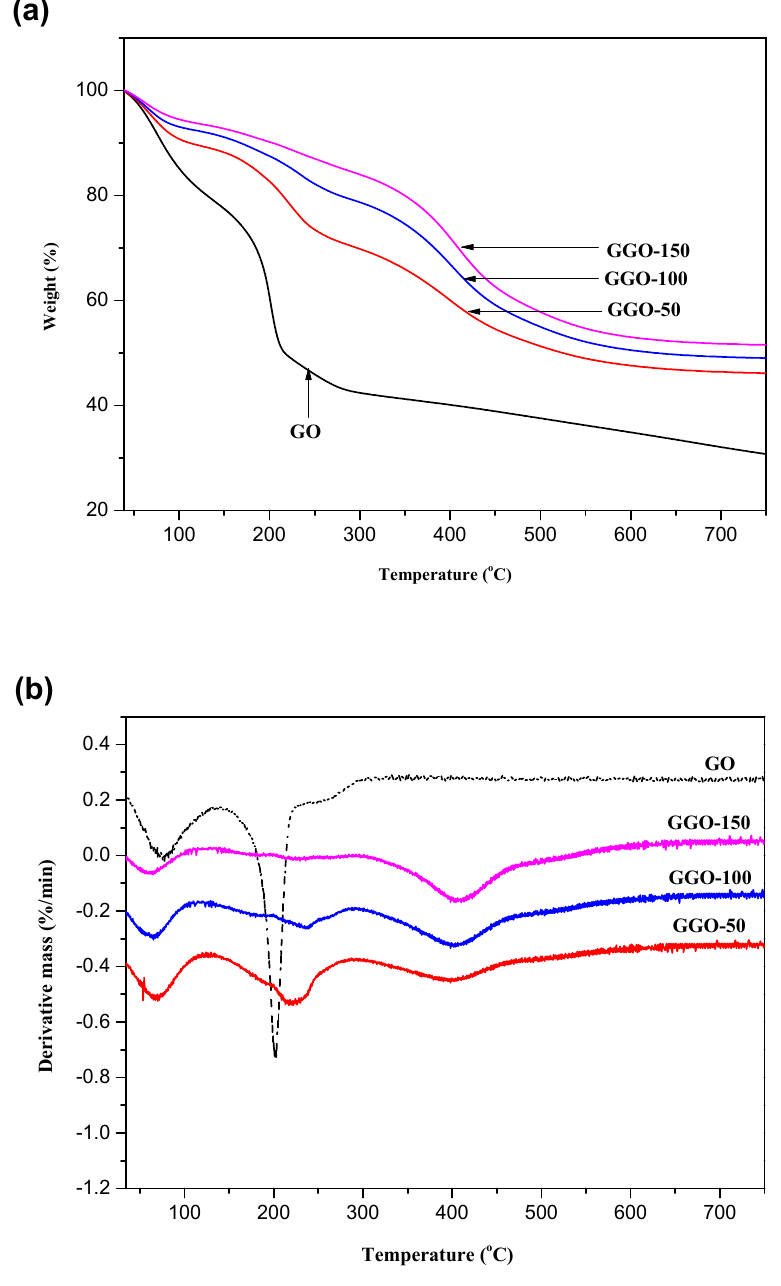
Figure 10. ( a ) TG and ( b ) DTG thermograms of GO, GGO-50, GGO-100, and GGO-150. Table 2. Percentage weight loss of GO and functionalized-GOs at various temperature regions Samples